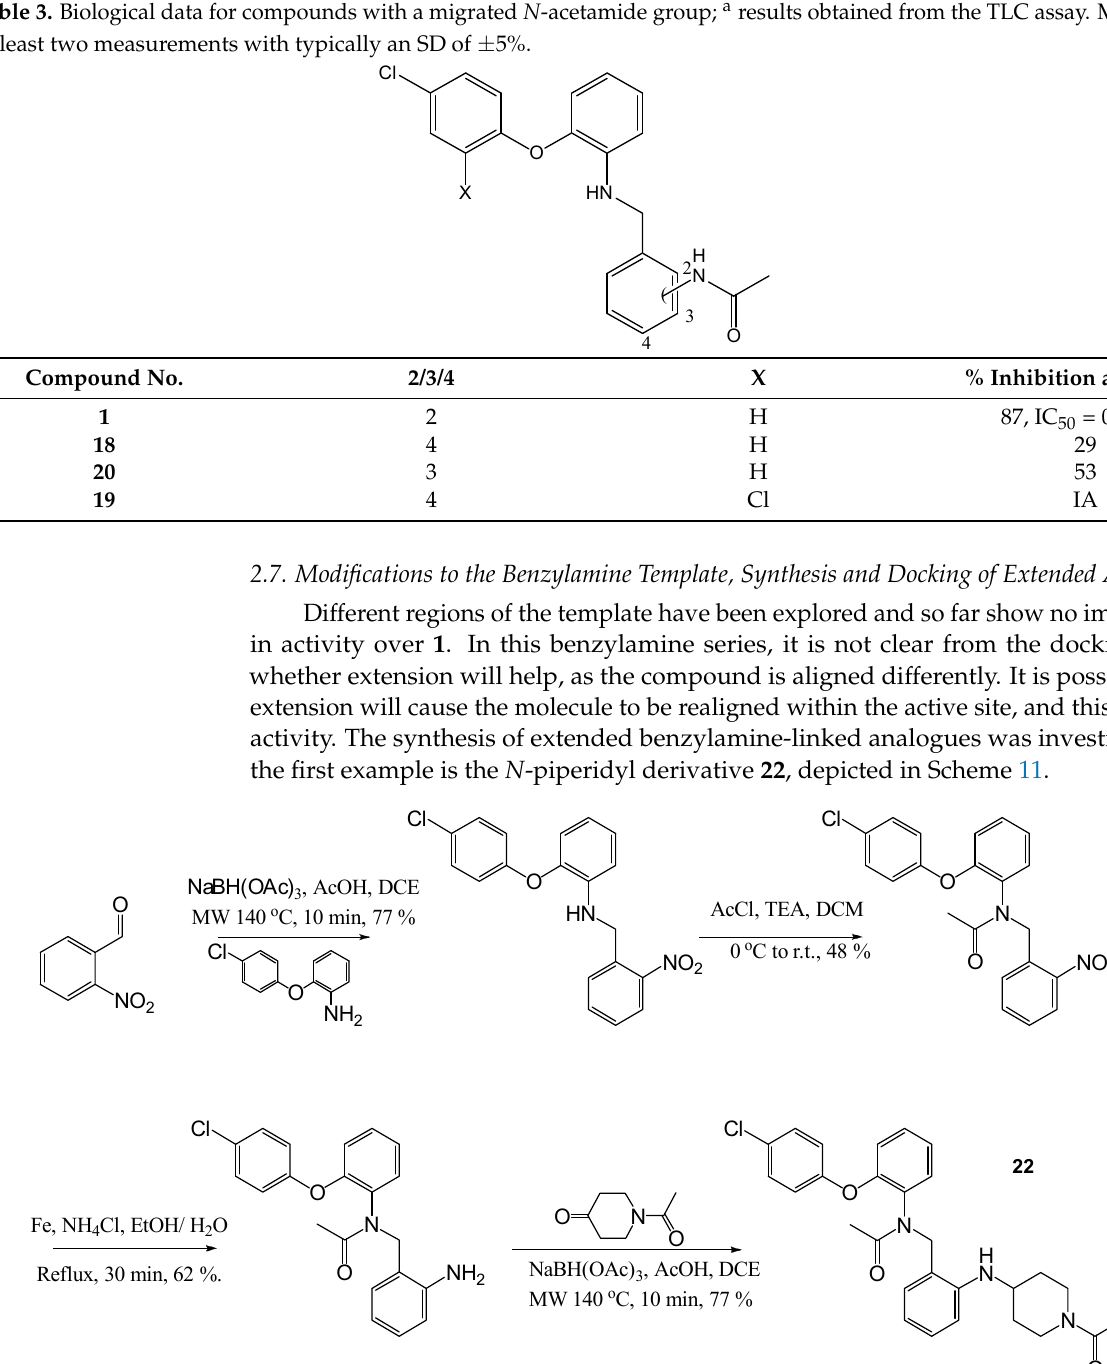
Fe, NH 4 Cl, EtOH/ H 2 O Reflux, 30 min, 62